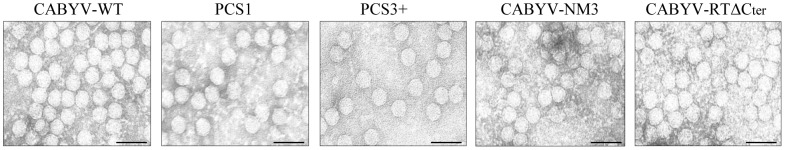
Viral particles of CABYV-WT, PCS1, PCS3+, CABYV-NM3 and CABYV-RTΔCter observed by transmission electron microscopy (TEM).A CABYV polyclonal antiserum was used to capture virus particles on the grids before TEM. Bars correspond to 50